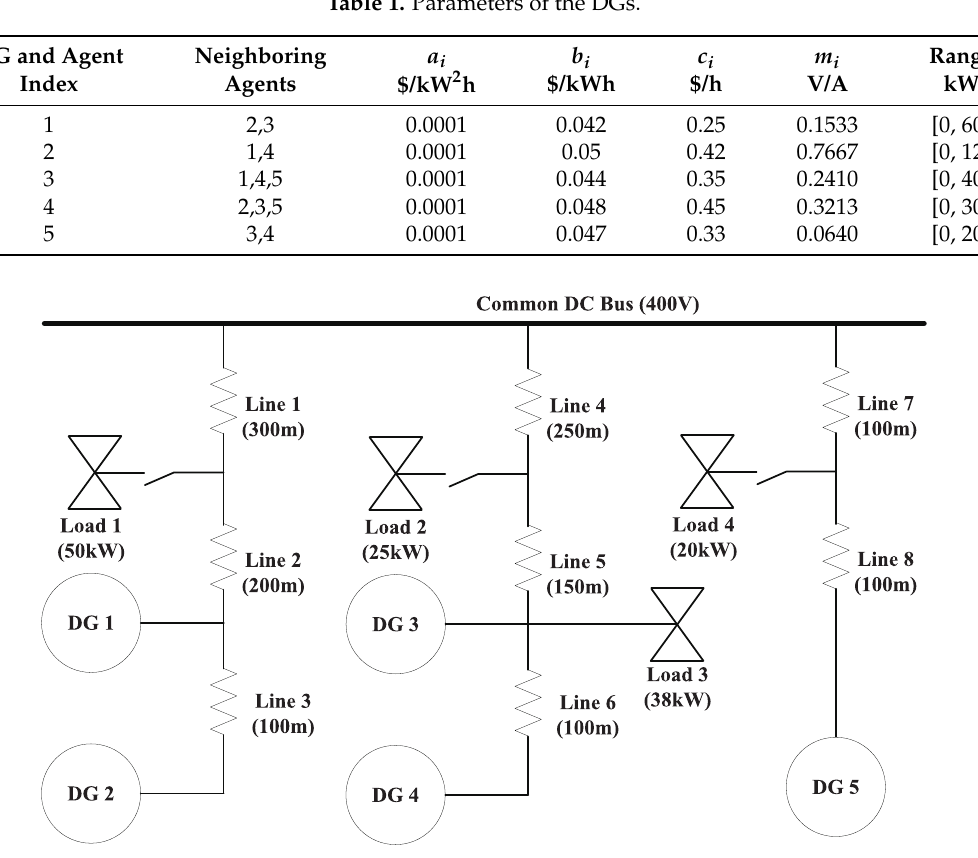
Figure 5. The system configuration of the DC microgrid test